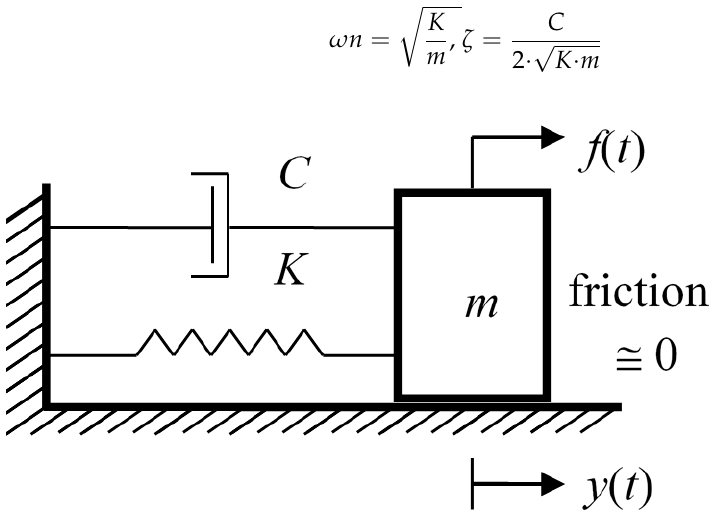
Figure 5. The simple harmonic oscillator featuring a mass m , moving due to the external force f , while constrained by the damping element with constant C and the spring element with constant K . The oscillator’s natural frequency ω n and damping factor ζ are in Formula